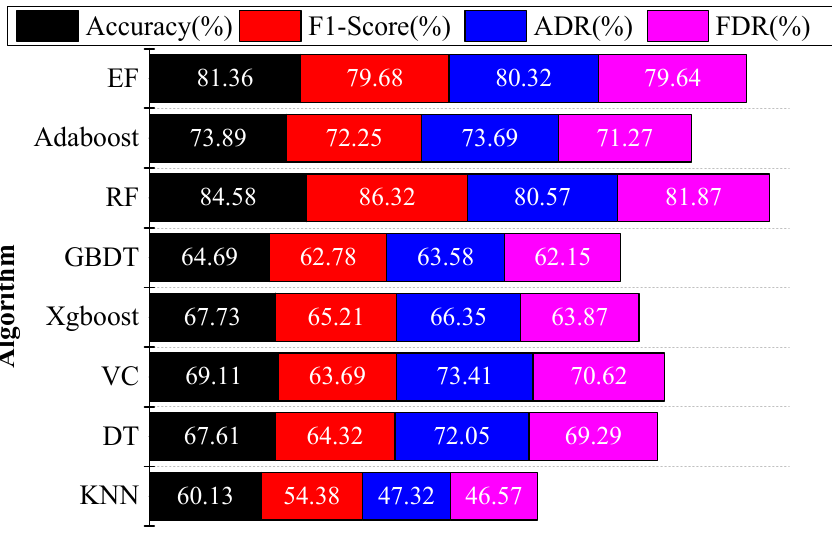
algorithm (EF). Excepting the decision tree and voting classifier algorithms, the parameter k of KNN and the number of base classifiers of other algorithms are obtained by the grid search algorithm.